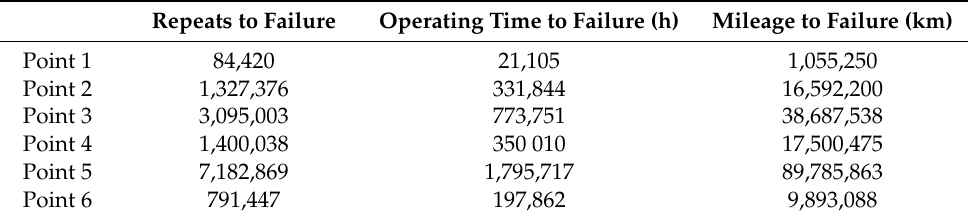
Table 1. Results of fatigue